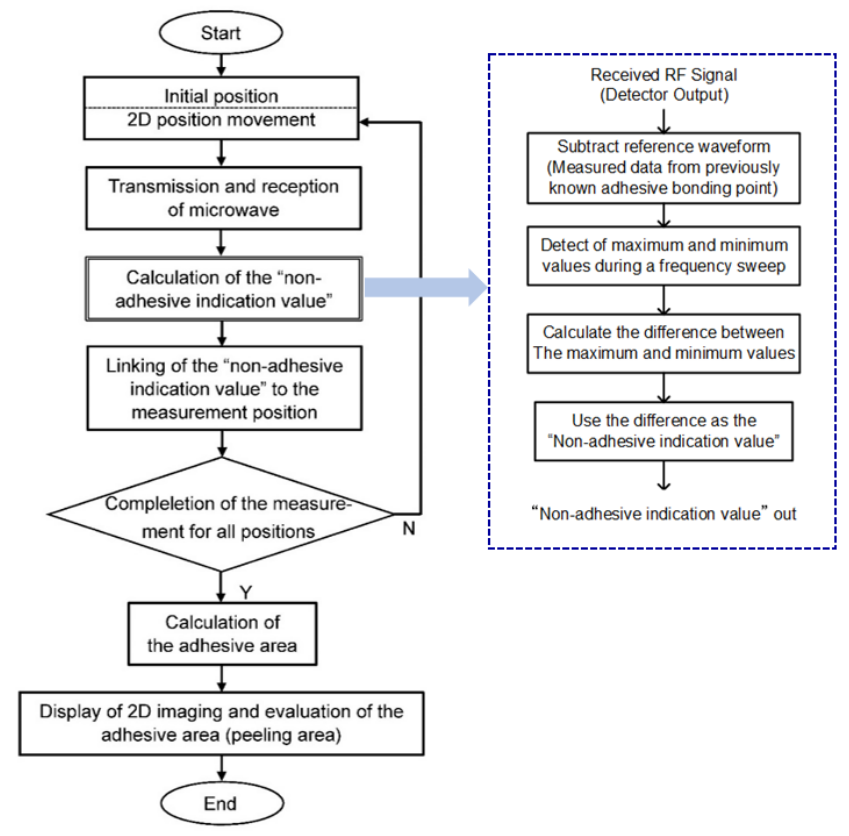
Figure 5. The overview flowchart of the signal processing algorithm.